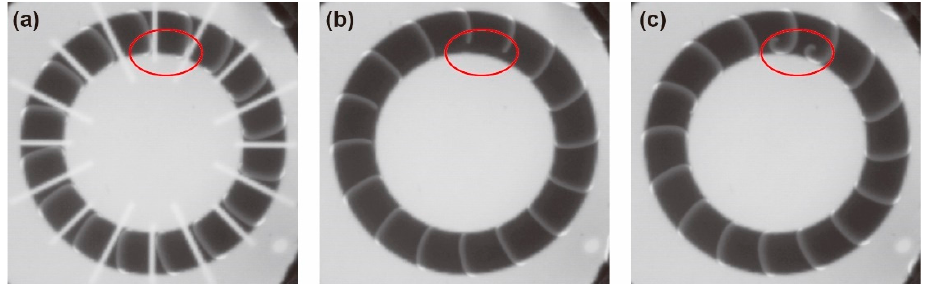
Figure 4. An example of failure to generate unidirectional chemical waves. The snapshots show the process of spiral waves formation owing to the image (i) in Figure 2a irradiated extremely long period. When a part of the chemical waves contacted the narrow line of light illumination (red circle in ( a )), the contacted regions of the chemical waves were inhibited ( b ). As a result, spiral waves were generated ( c ).